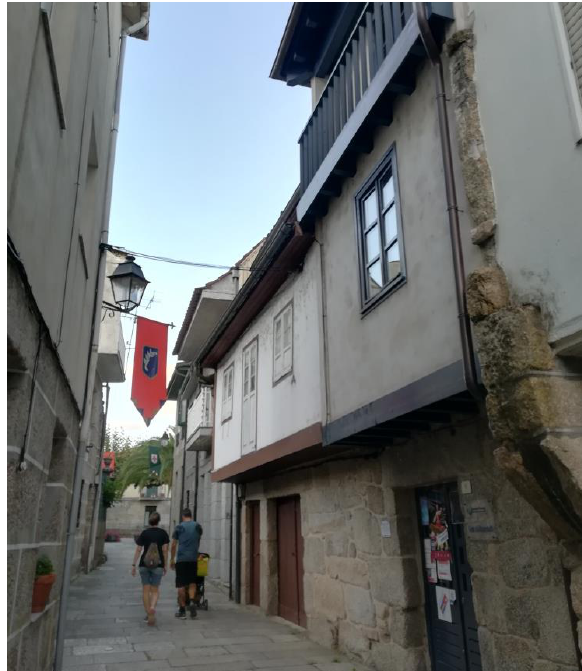
Figure 19. Cantilevered half-timbered houses in Ribadavia. Source: